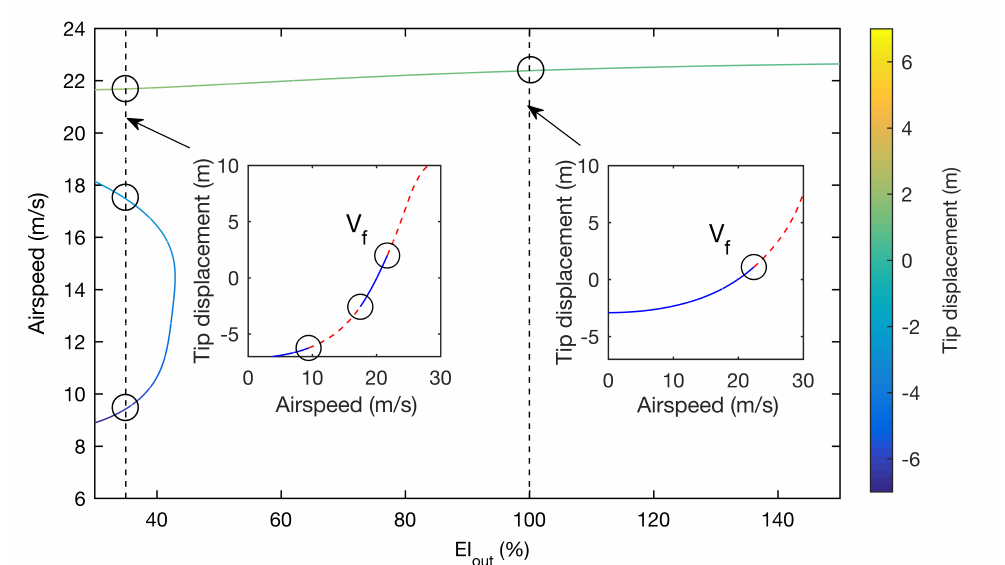
Figure 10. Two-parameter continuation of Hopf bifurcations for varying out-of-plane stiffness and airspeed. One-parameter equilibria continuations are shown for EI out = 35% and 100%.